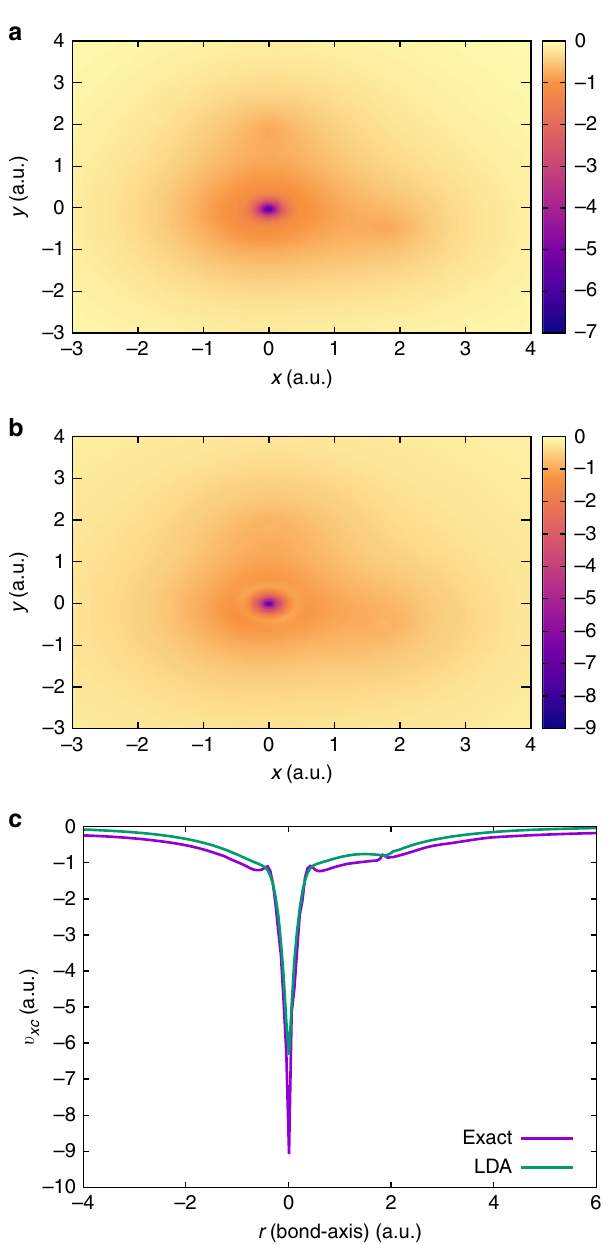
) for H 2 O . xc (in a.u.) is xc